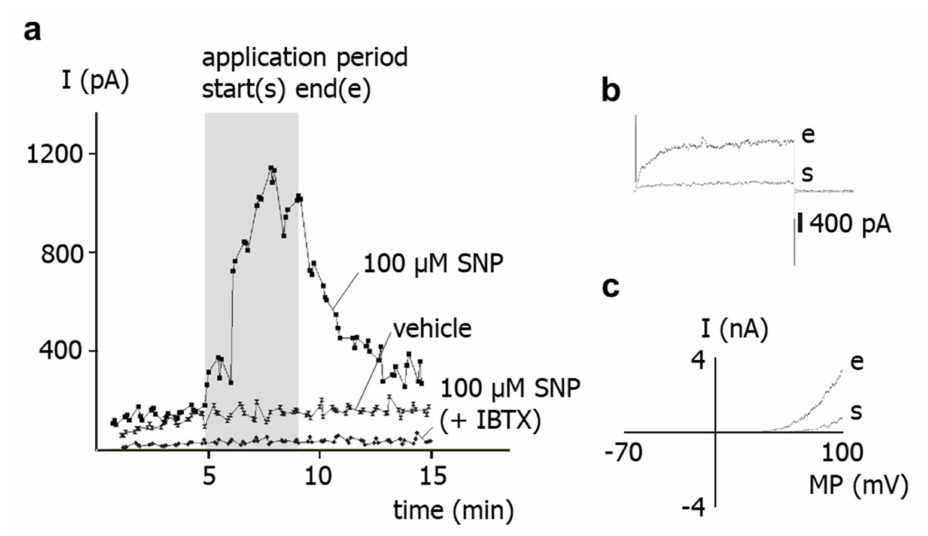
Figure 1. Effect of the NO-donor SNP on the outward current of rat tail artery smooth muscle cells. ( a ) Examples of the time course of the effect of SNP, SNP in the presence of 300 nM iberiotoxin (IBTX), and experimental bath solution (vehicle) on the outward current. The application period is shown as grey area; start of application is marked as (s), end of application as (e). The current was elicited with use of a 500 ms-long voltage step from a holding potential of − 40 mV to a test potential of +70 mV. ( b ) Examples of traces of the outward current elicited with use of a 500 ms-long voltage step from a holding potential of − 40 mV to a test potential of +70 mV at the start (s) and at the end (e) of the application of SNP. ( c ) Examples of current–voltage (I–MP) relationships of the outward current elicited with use of a 1.5 s-long voltage ramp from a holding potential of − 40 mV in the voltage range from − 70 to +100 mV at the start (s) and at the end (e) of the application of